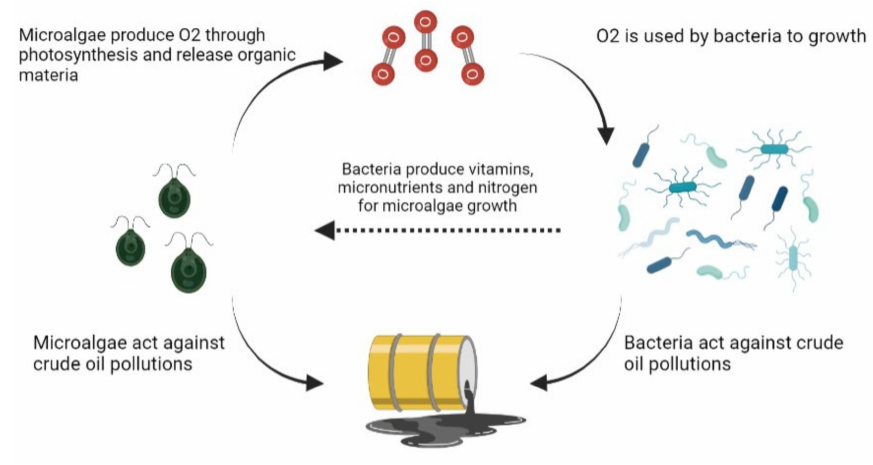
Figure 1. Microalgae and bacteria consortium: mechanisms of